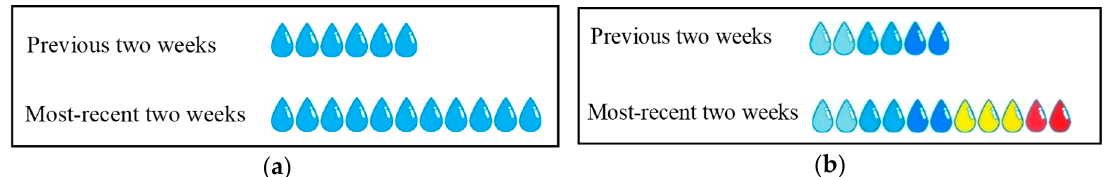
Figure 1. An example of the water droplet pictures shown to the intervention groups: ( a ) Illustration for the blue drop group; ( b ) Illustration for the colour drop group. The number of water droplets in the initial two weeks was always six. This was then changed to between one and eleven according to the rate of change from the previous period.